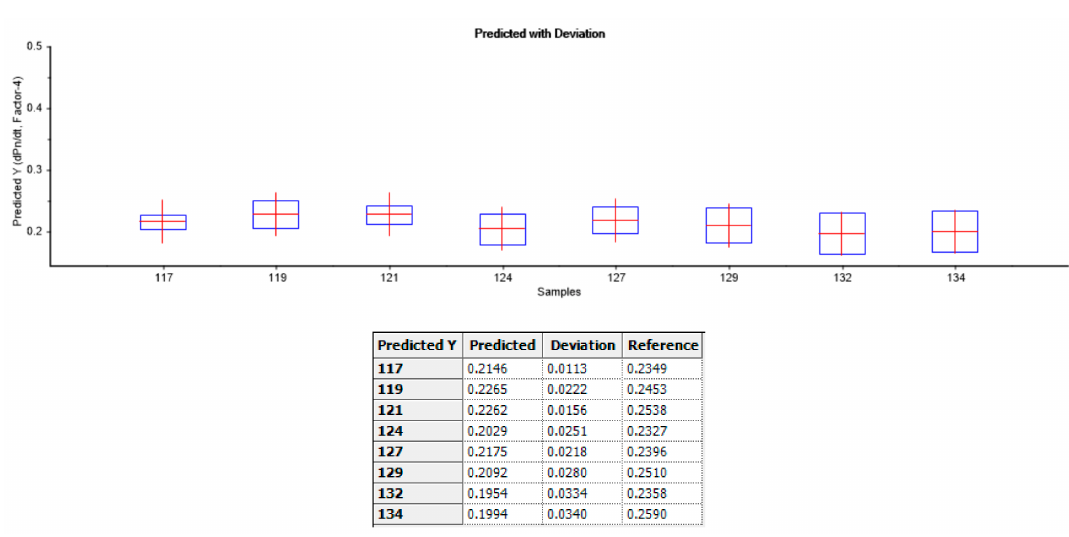
Figure 6. Prediction results for the new data from Period C for four factors using the derived PLS model for the relevant